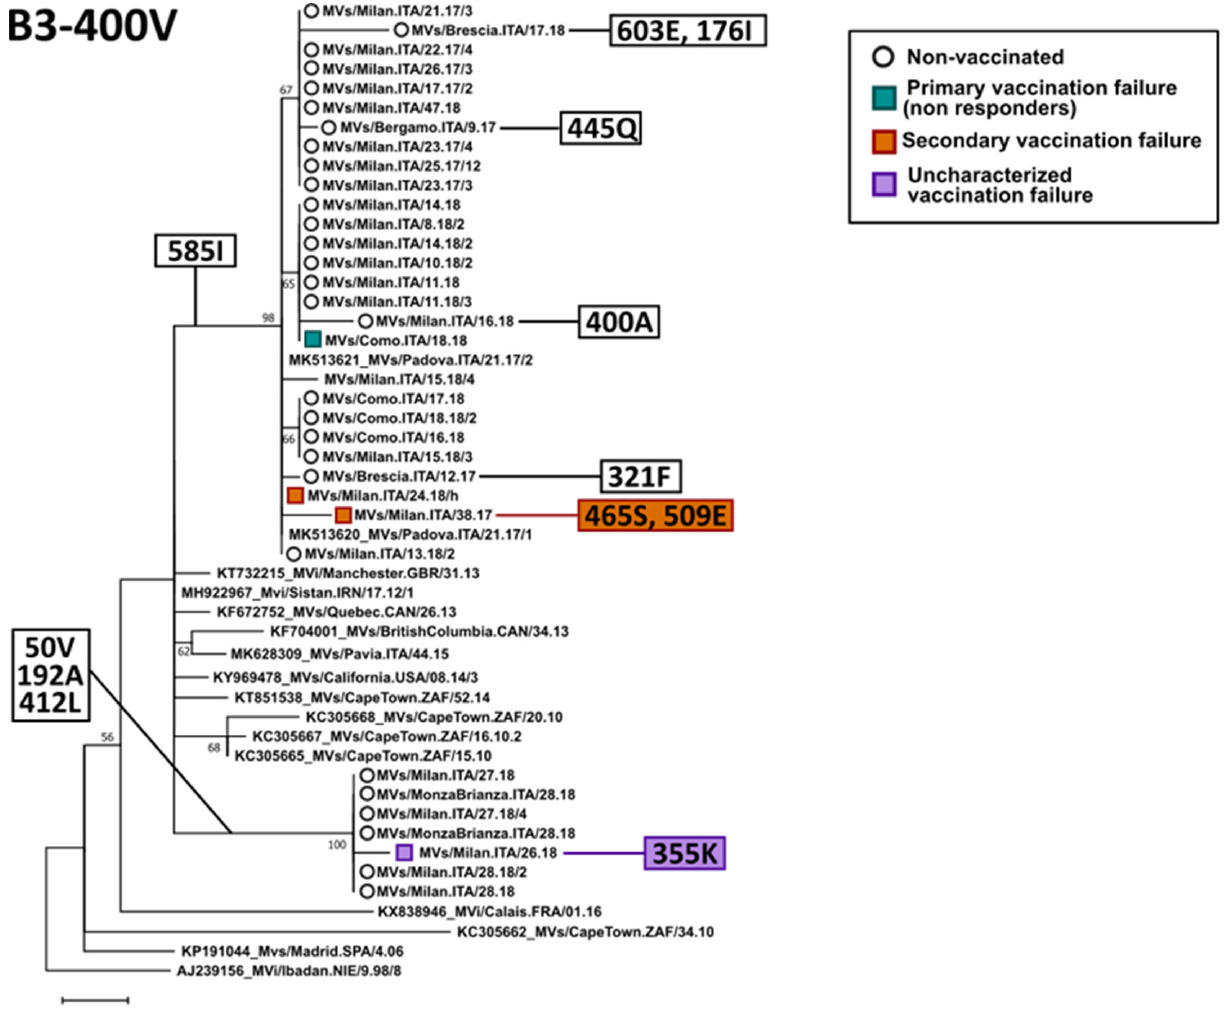
Figure 3. Phylogenetic analysis of genotype B3 H nucleotide sequences belonging to clade B3-400V.